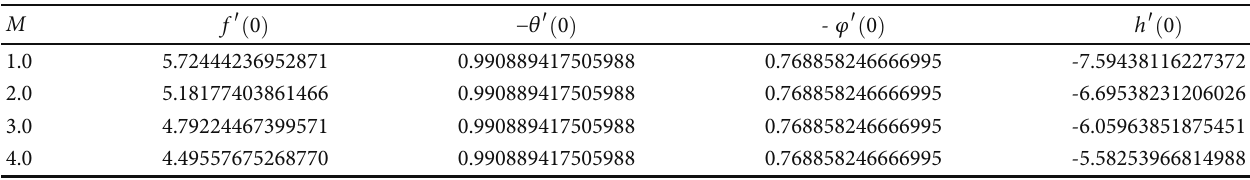
Table 4: Values of skin friction coe ffi cient, heat transfer and mass transfer for magnetic variation with γ = 45 ° , c = 0 : 5 , Pr = 0 : 71 , Sc = 0 : 22 ,